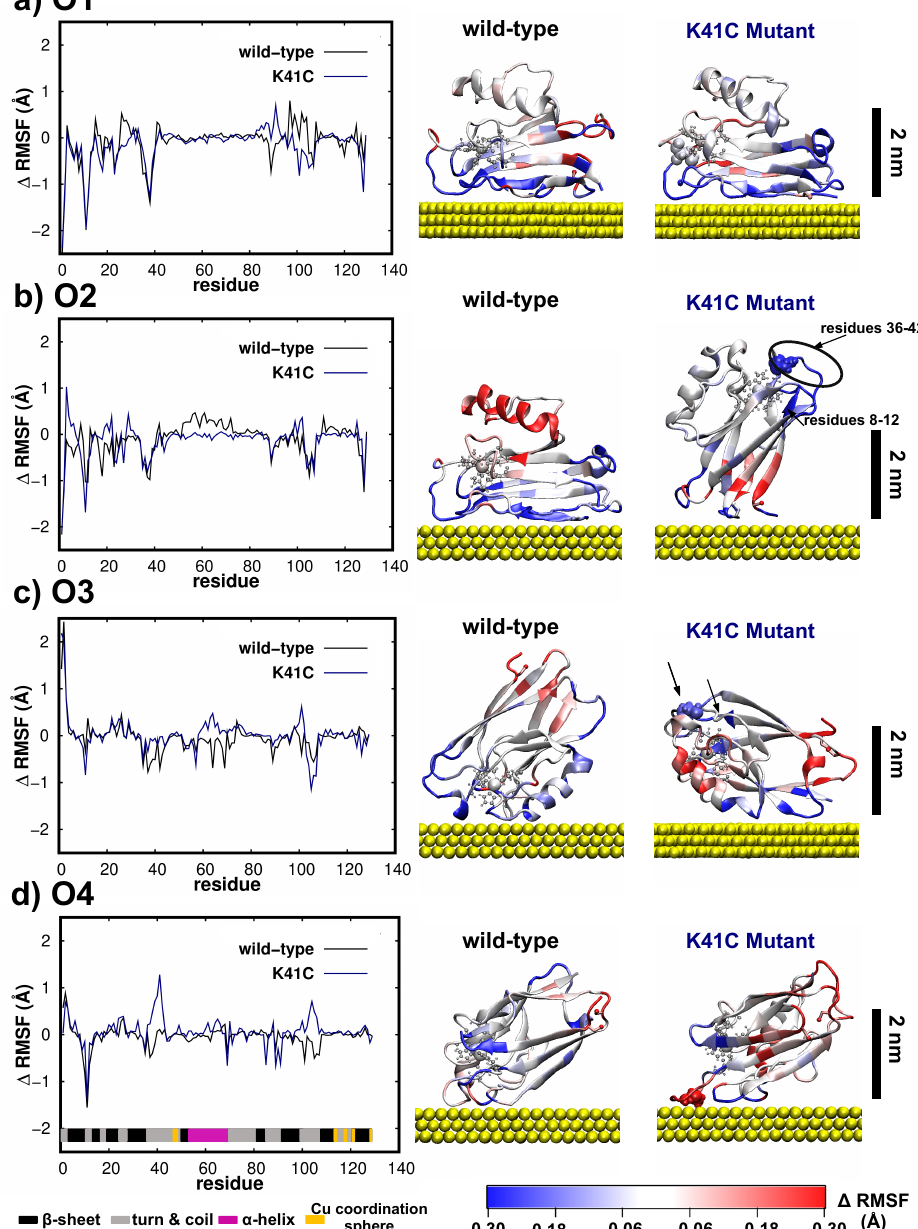
Figure 7. Differential fluctuations of the wild-type and K41C proteins adsorbed with respect to wild-type protein in solution. Here we show the ∆ RMSF = RMSF adsorbed − RMSF wild − type , free averaged from the last 70 ns of simulations for the four initial orientations ( a ) O1, ( b ) O2, ( c ) O3 and ( d ) O4. On the left column in black/blue we represent the ∆ RMSF value of the wild-type/K41C per amino-acid. The secondary structure character of each amino-acid when the wild-type protein is free solved in water is also specified (see Figure 4). In the right column we show ∆ RMSF projected in the equilibrium adorption configuration. The position of the K41C mutation is highlighted with a van-der Waals representation. The Azurin color representation is the same as in Figure